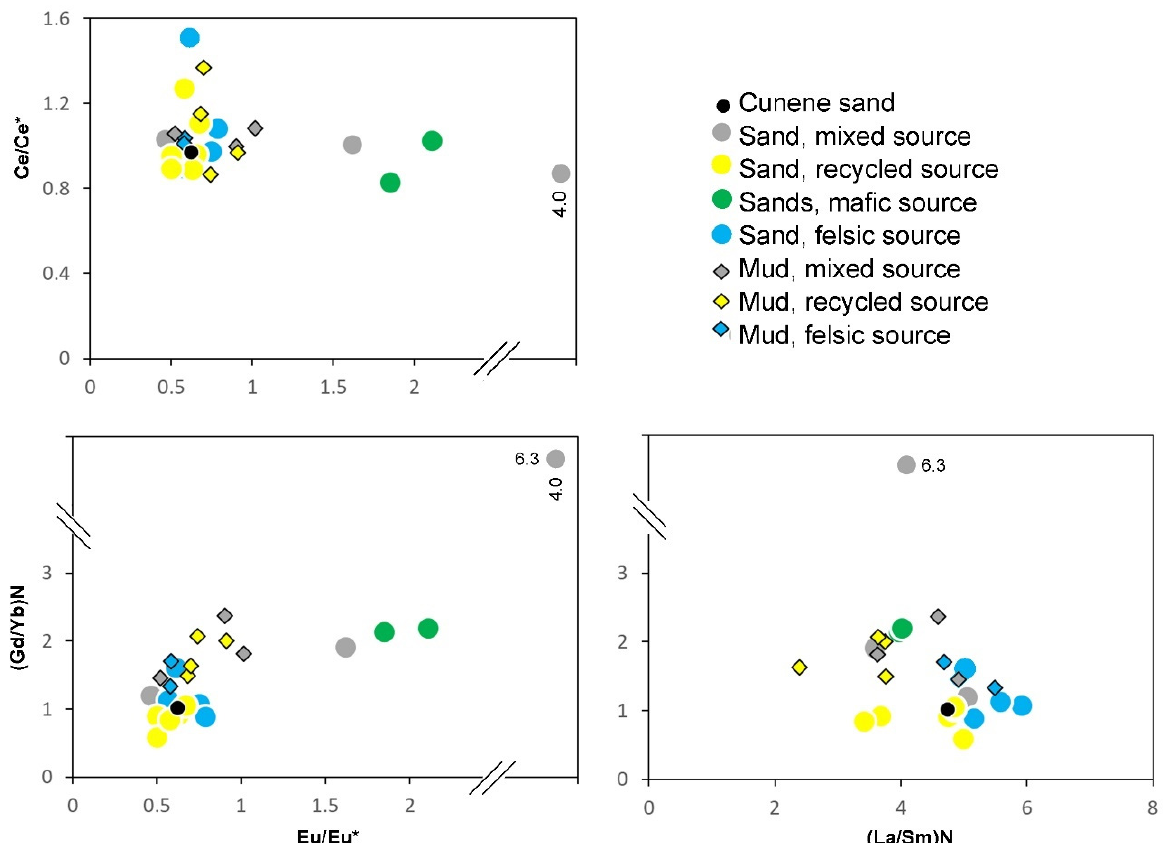
Figure 6. Biplots of characteristic fractionation and anomaly parameters for REE geochemistry.